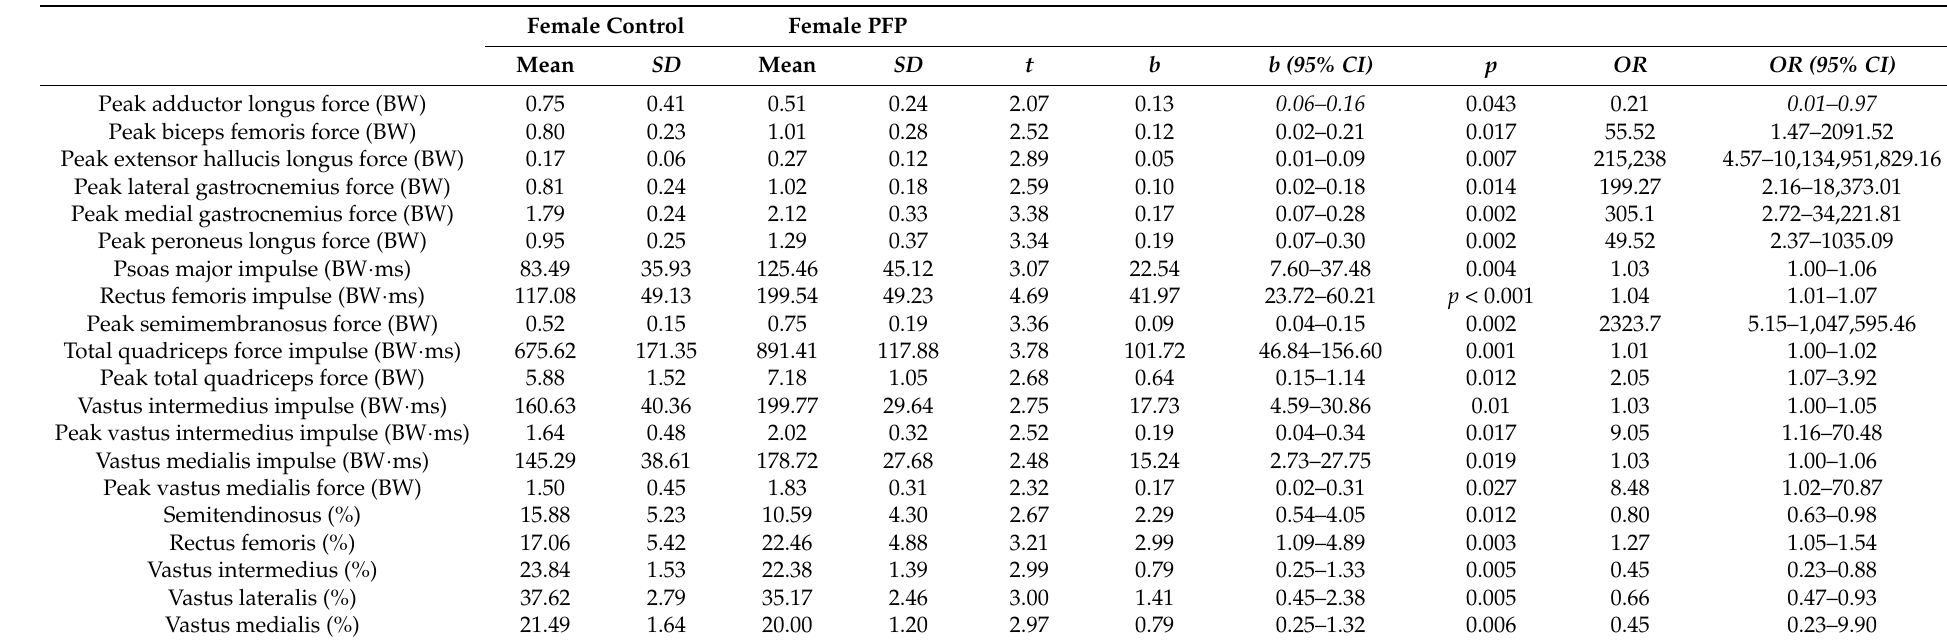
Table 9. Muscle force indices in female PFP participants and